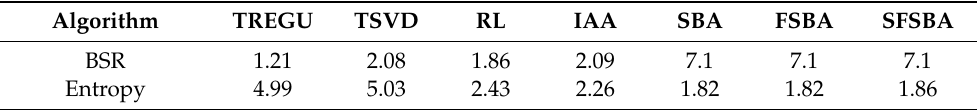
Table 5. Performance indexes of real data